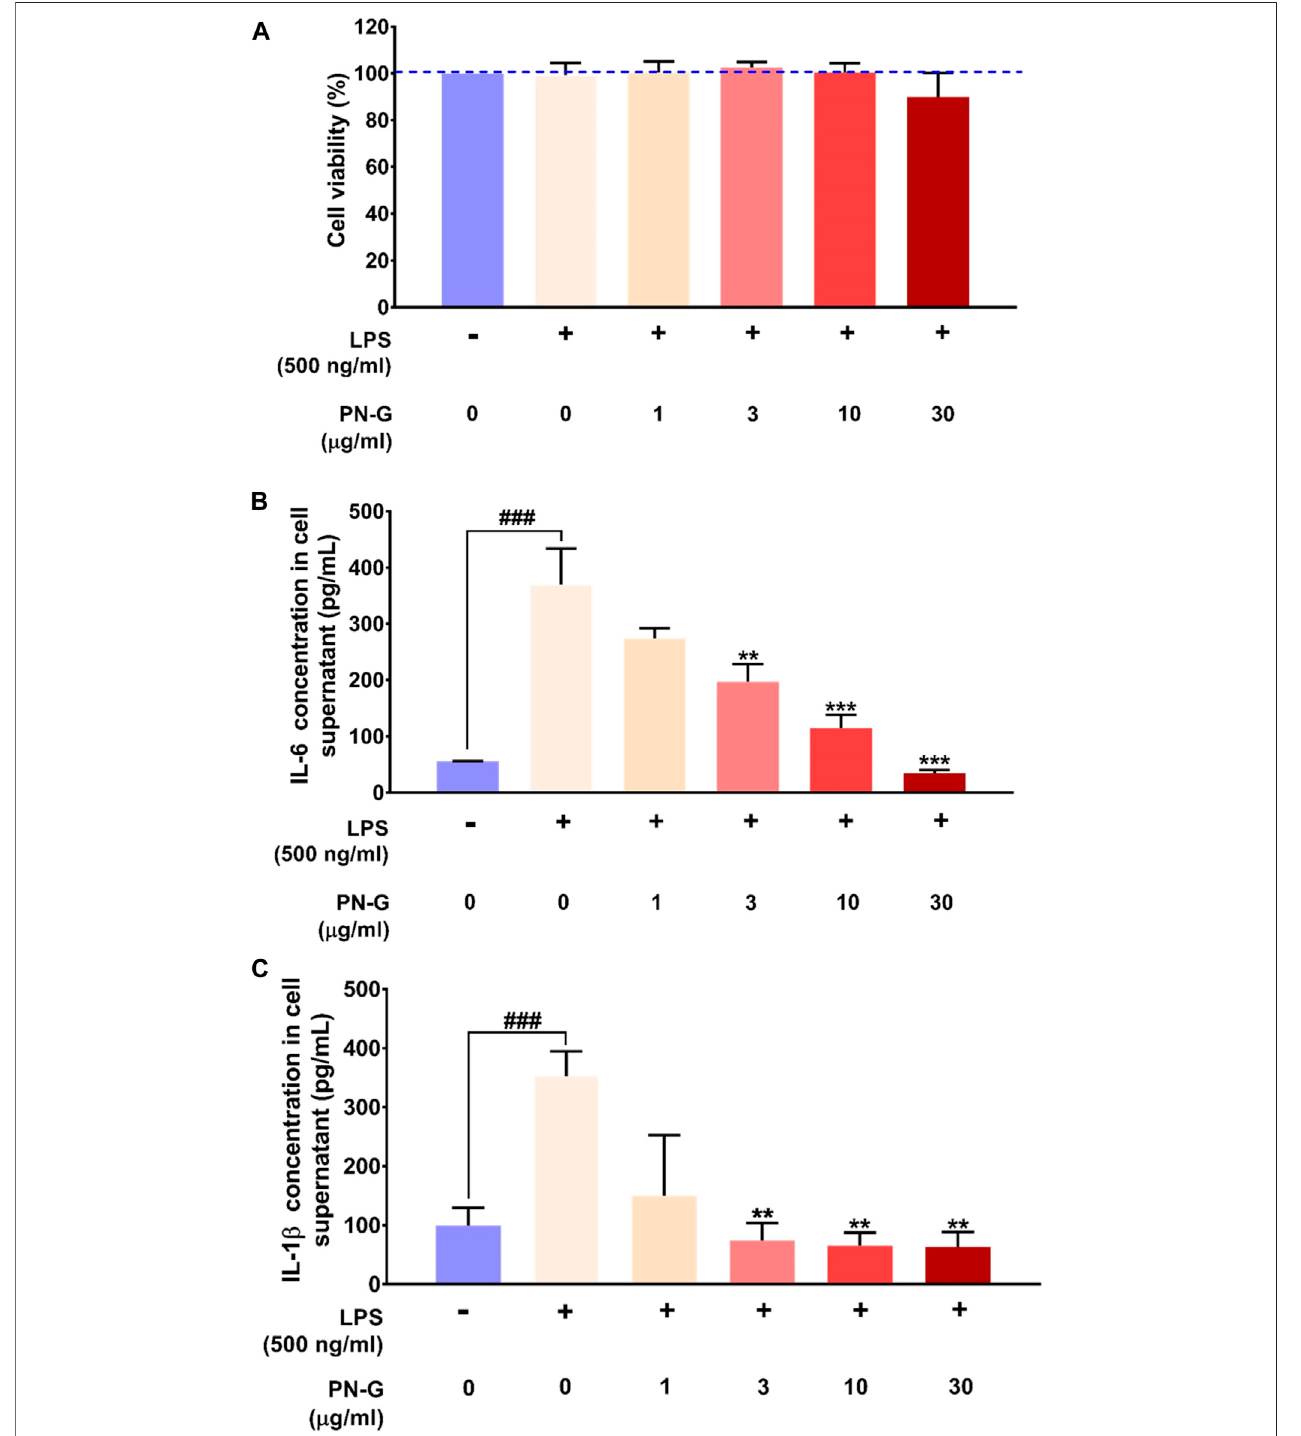
FIGURE 2 | PN-G exhibited anti-in fl ammatory property at cytosafe doses. (A) Bar graph showing the in vitro safety of PN-G treatment on THP-1 cells at different concentrations and, by extension, the suitability of the LPS-induced in vitro in fl ammatory model for subsequent experiments. (B,C) Graphical representations of the effect of PN-G treatment on release of different pro-in fl ammatory cytokines, namely, IL-6 (B) and IL-1 β (C) from LPS-induced in fl amed THP-1 cells. Data is represented as mean ± SEM. The statistical signi fi cance of the observed effect was analyzed through one-way ANOVA followed by Dunnett ’ s multiple comparison test and represented as ### for p < 0.001, when compared with normal cells, untreated with LPS or PN-G. When the comparison was with the PN-G untreated, LPS-induced cells, the statistical signi fi cance is depicted with ** and *** for p < 0.01 and < 0.001, respectively.